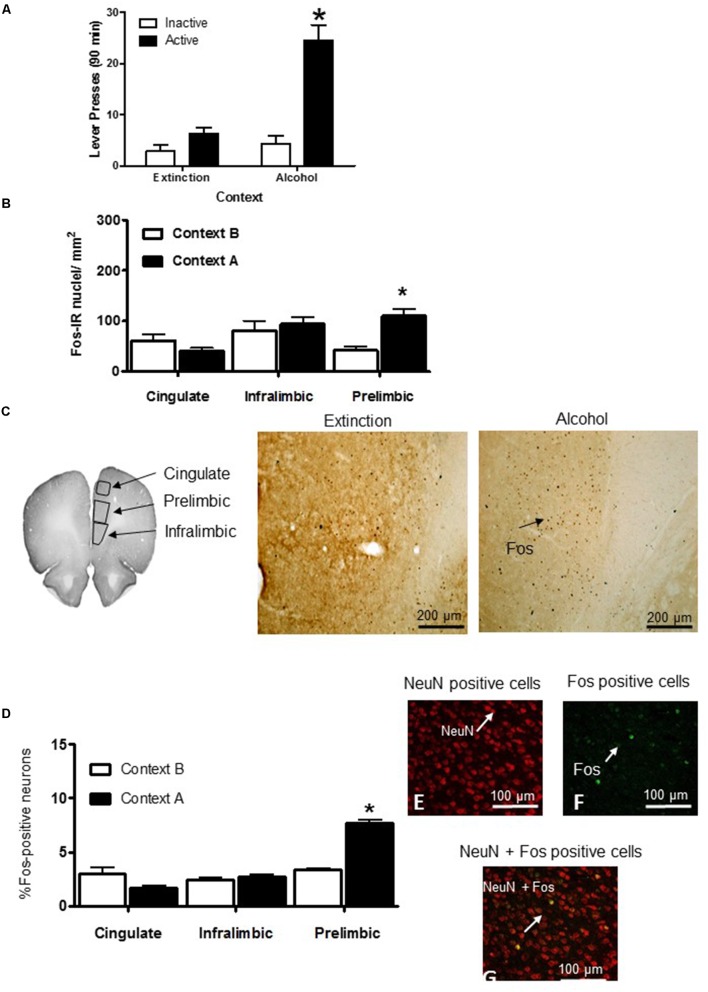
Context-induced reinstatement of ethanol seeking increased the Fos expression in the prelimbic cortex. Data depict the mean (±standard error of the mean). (A) Test: Total number of active lever and inactive lever presses in rats tested in contexts A and B. ∗Different from context B, p < 0.05, n = 9–17 per group. (B) Number of Fos-immunoreactive (IR) nuclei per mm2 in the cingulate, infralimbic, and prelimbic cortex. (C) Areas used for quantifying the Fos-IR neurons in the cingulate, infralimbic, and prelimbic cortex of rats. ∗Different from context B, p < 0.05 (n = 9–17 per group). (D) Percentage of neural activation by double-labeling with Fos and NeuN [(Fos+/NeuN+cells) × 100] per mm2 in the cingulate, infralimbic, and prelimbic cortex. (E) Red: neuronal nuclei marker NeuN. (F) Green: Fos expression. (G) Yellow: Fos + NeuN double-labeled nuclei. Scale bar = 100 μm, n = 4 per group.